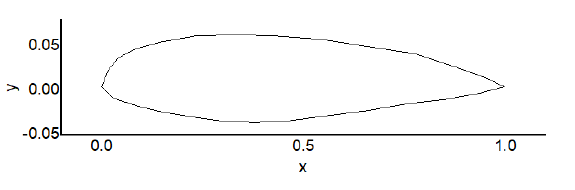
Figure 8. BAC474 airfoil developed in XFLR; it is used for the Boeing 747-200 wing